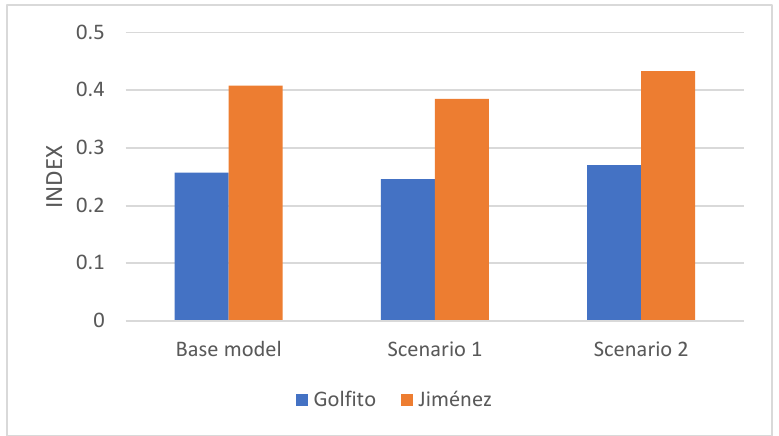
Figure 6. Global sustainability index for each scenario.